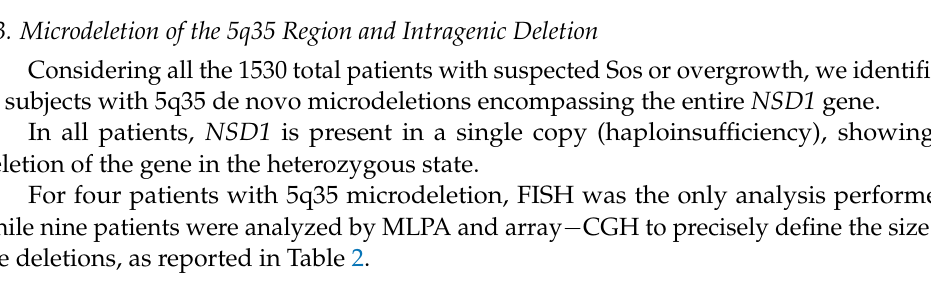
Table 2. Chromosomal arrangement in SoS